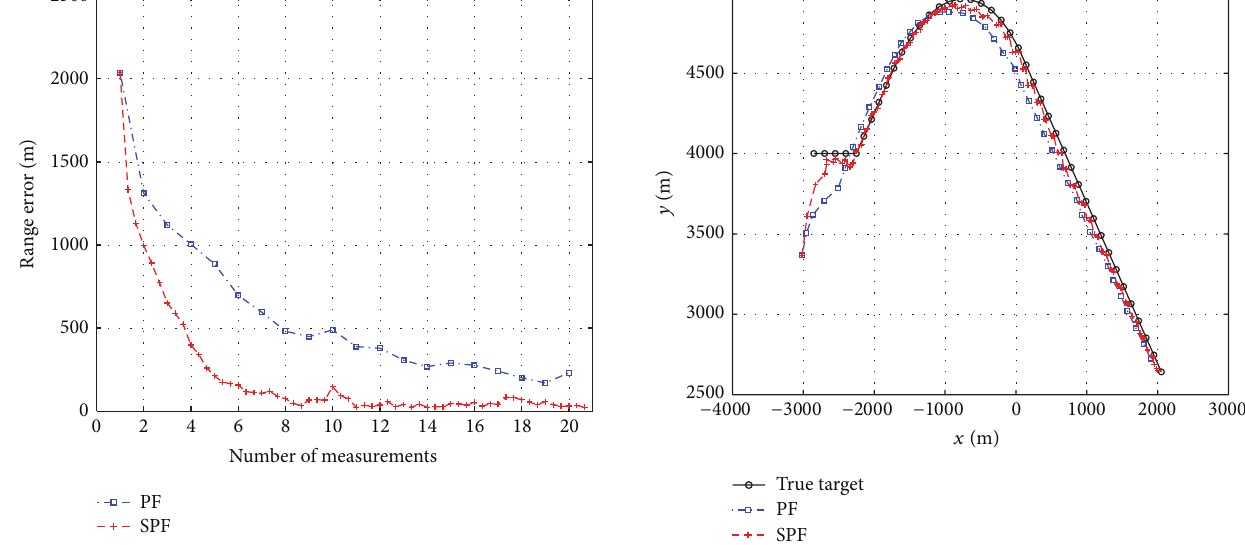
Figure 12: Tracking performance for a maneuvering target (20MC